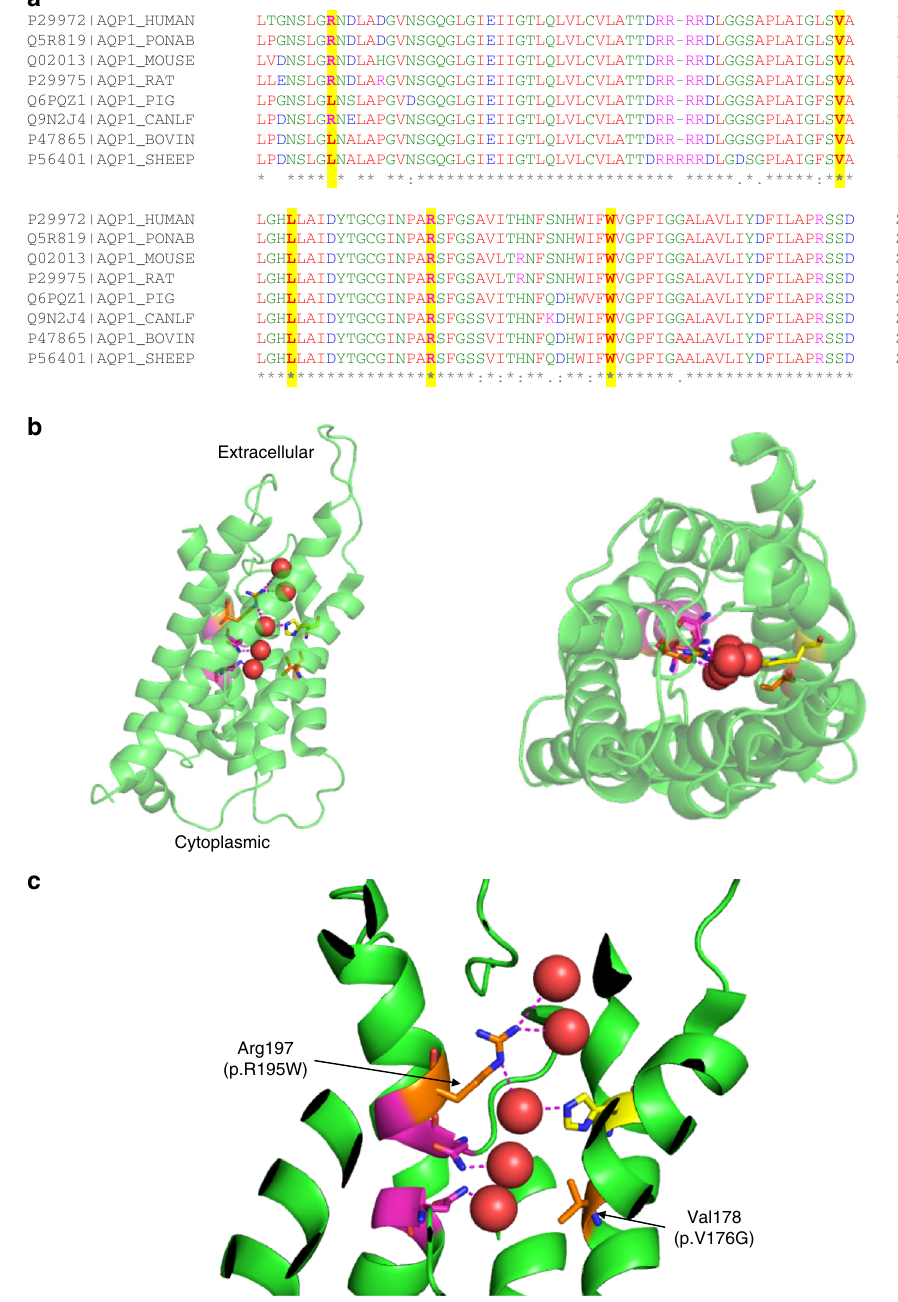
Fig. 7 Structural analysis of AQP1 mutations. a Multiple sequence alignment of human AQP1 with seven other mammals. The bovine AQP1 has the high resolution (2.2 Å) published structure. Mutations identi fi ed in PAH cases are highly conserved and highlighted in yellow. b Crystal structure of bovine AQP1 (PDB: 1j4n) 22 . Left: side view; right: top view from the extracellular direction. AQP1 is shown as a semi-transparent cartoon and fi ve water molecules in the water channel are shown as red spheres. Key residues lining the water channels are represented with stick structures. c Magni fi ed view of the water channel, with H-bonds connected to water molecules in the channel highlighted. Two asparagine-proline-alanine (NPA) motifs, essential for the water transporting function of AQP1, are shown in magenta. Conserved His180 that constricts the water channel is shown in yellow. Mutations found in PAH cases, Arg195Trp and Val176Glu, are labelled and shown as orange stick structures. Arg195 and His180 are highly conserved in the known water channels and are strong indicators of water channel speci fi city. Arg195Trp and Val176Glu mutations are predicted to disrupt the conformation of this conserved water